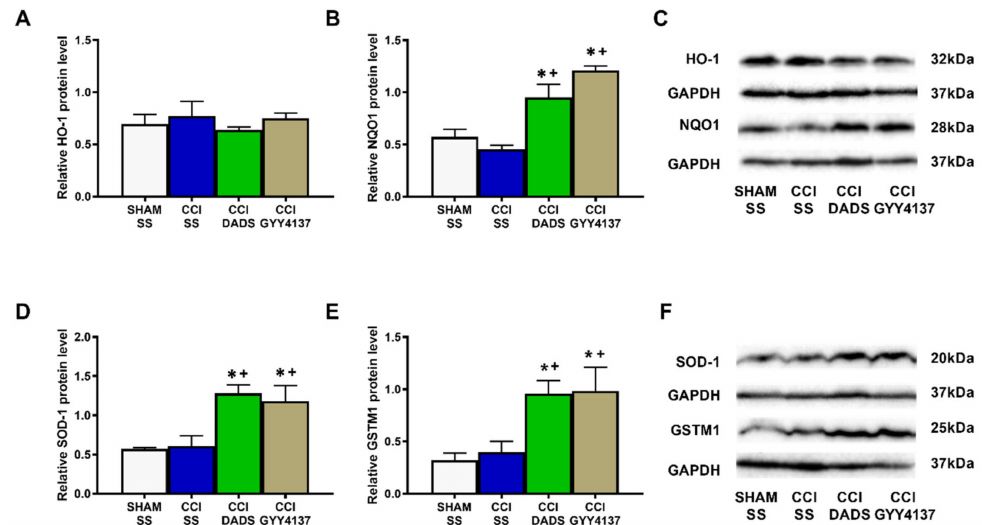
Figure 6. The influence of DADS and GYY4137 treatments on the HO-1, NQO1, SOD-1, and GSTM1 expression in the DRG of animals with neuropathic pain. Both treatments increased the expression of NQO1 ( B ), SOD-1 ( D ), and GSTM1 ( E ) in the DRG of mice with nerve injury-provoked neuropathic pain. No variations in HO-1 levels were identified ( A ). We used sham-operated (SHAM) mice treated with SS as a control group. All proteins are expressed in relation to GAPDH levels. Blots for HO-1 and NQO1 ( C ), as well as for SOD-1 and GSTM1 ( F ), are displayed. In all pictures, * symbolizes significant differences vs. SHAM-animals treated with SS and + vs. CCI-mice injected with SS ( p < 0.05; one-way ANOVA followed by Tukey test). Each column represents the mean, and vertical bars indicate SEM ( n = 3 samples).